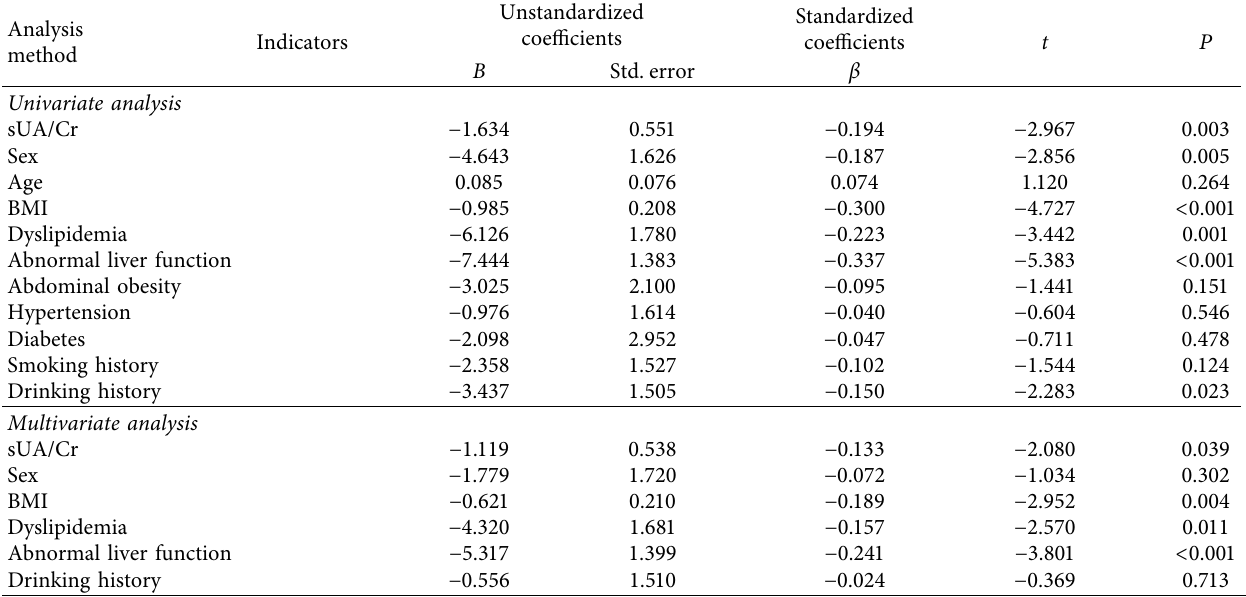
Table 2: Univariate and multivariate linear regression analyses of liver computed tomography value.